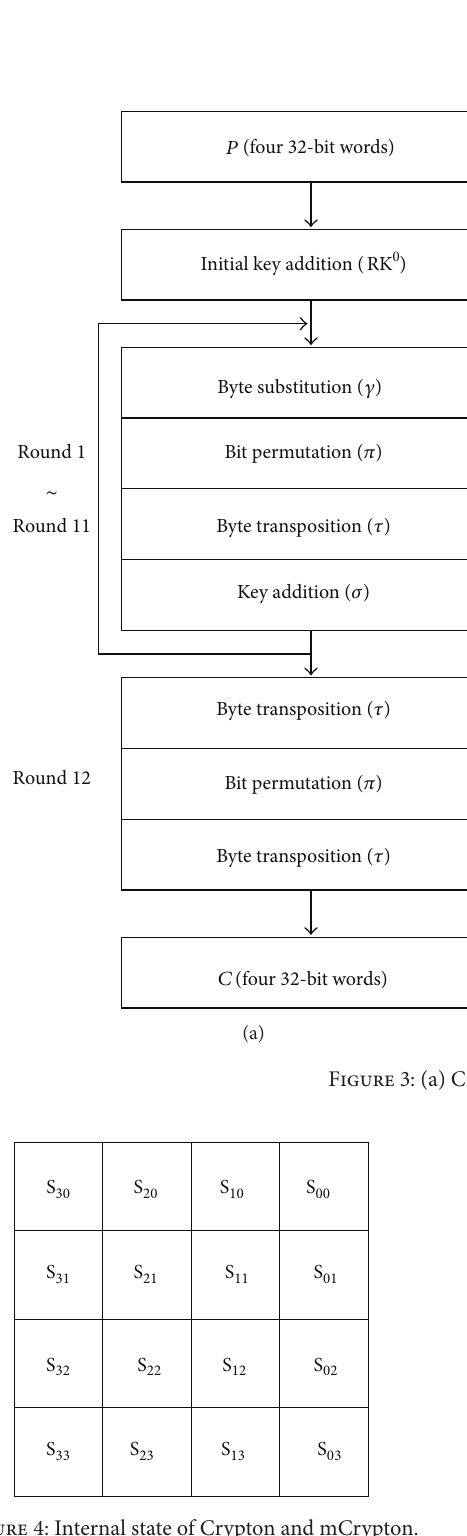
Figure 4: Internal state of Crypton and